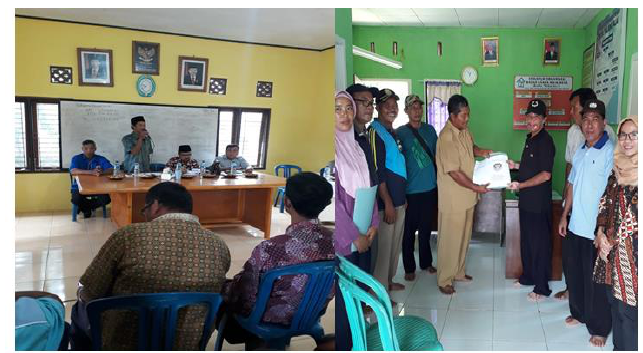
Figure 1: Musrembangdes activities and document submission